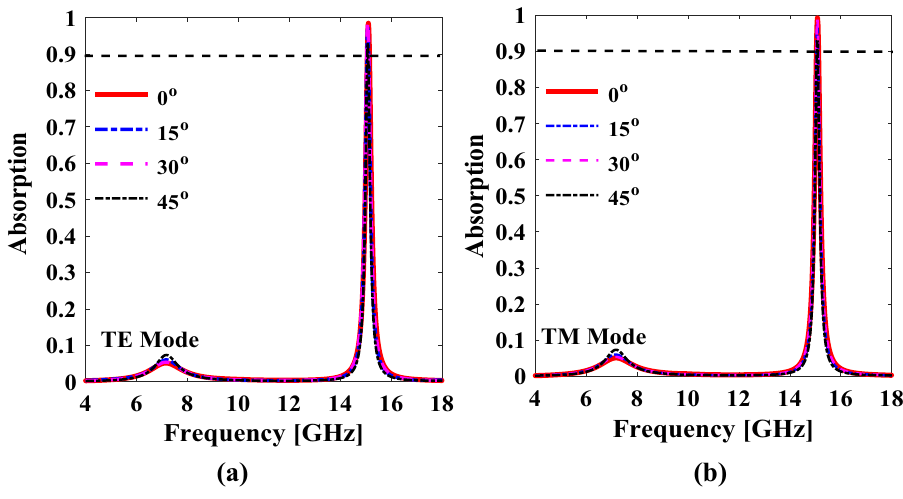
Figure 9. Incident angle increased from 0° to 45° ( a ) TE Mode ( b ) TM Mode. *The figure is created using MATLAB ver. R2020A-URL: https:// www. mathw orks. com/ produ cts/ matlab. html.